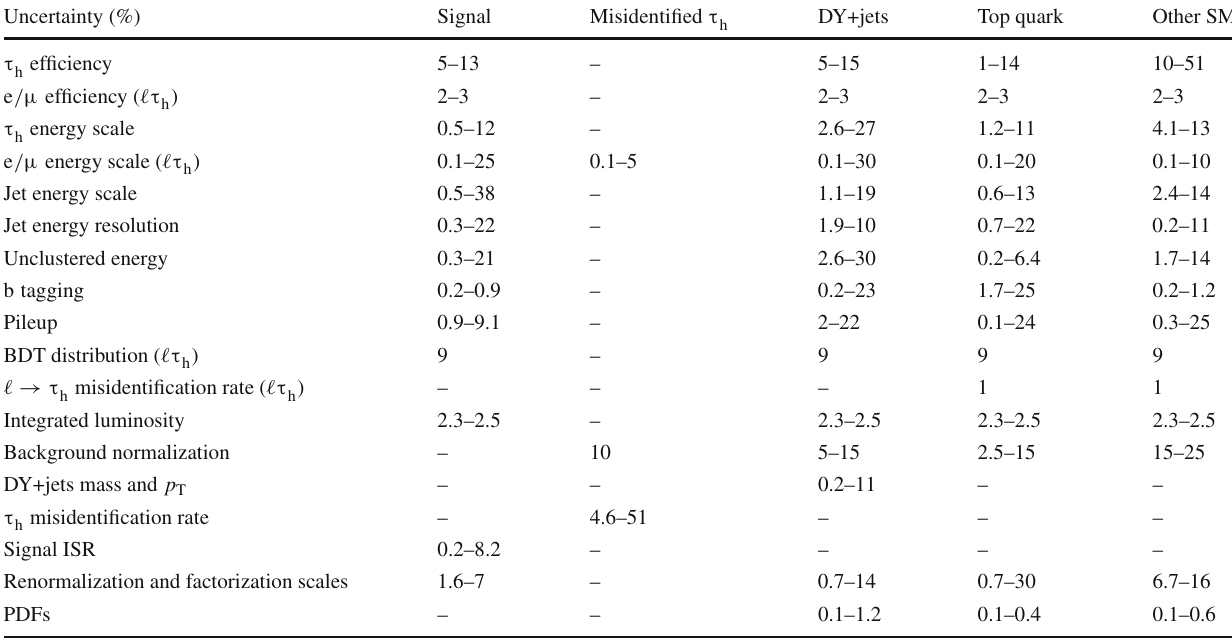
Table 2 Systematic uncertainties of SM background predictions and a representative signal model, corresponding to a left-handed (cid:2) τ , with m ( (cid:2) τ ) = ) = 1GeV. The uncertainty ranges are given in percent. The spread of values reflects uncertainties in different 100GeV and m ( (cid:2) χ 0 1